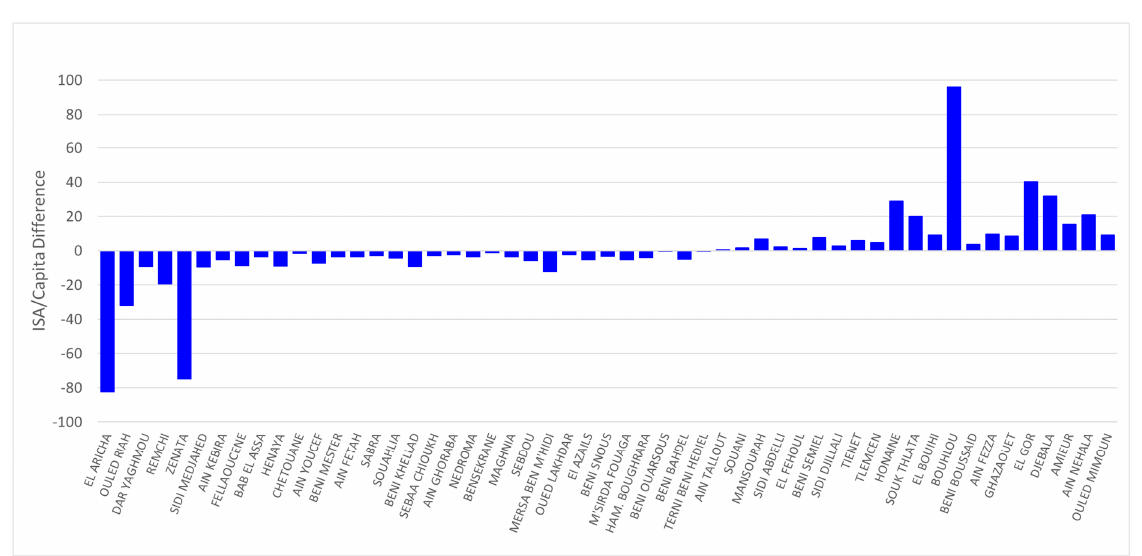
Figure 7. Difference of impervious surface area per capita (m 2 /person) for the communes in the Tlemcen wilaya between 2008 and 2018.